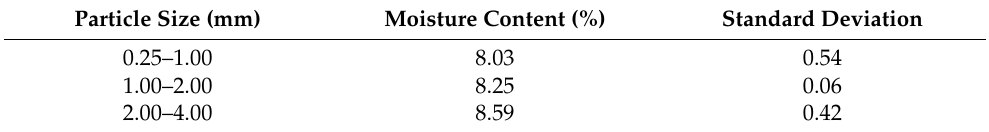
Table 2. Humidity of the particles used in the manufacturing of the